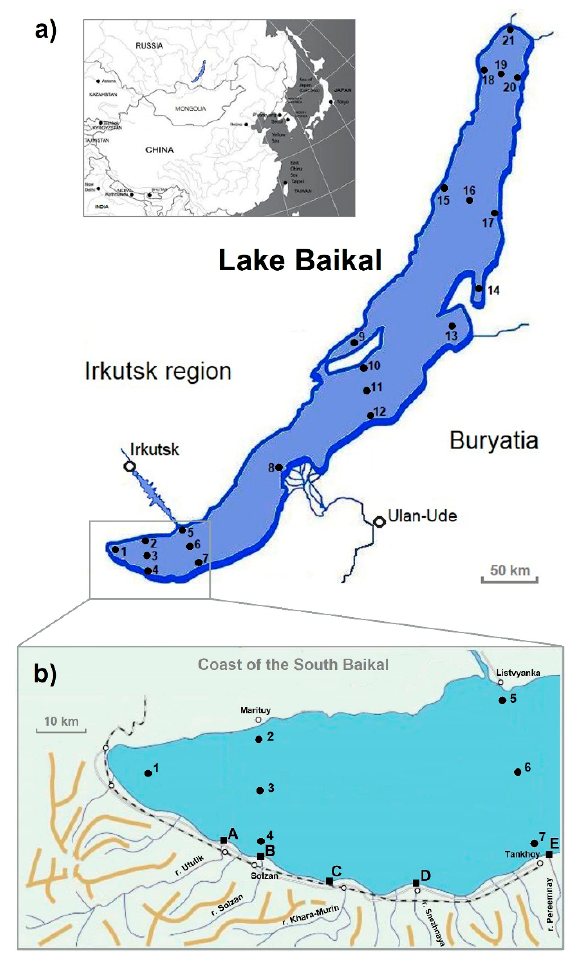
Figure 1. Map of Lake Baikal and sampling sites: ( a ) Water sampling stations in the pelagic zone of Lake Baikal; ( b ) Water sampling stations in the tributaries in the southern basin of Lake Baikal. PAHs were extracted with 25 mL of n-hexane from 1 L of unfiltered water because the concentration of suspended particles does not exceed 0.01 to 0.05% in Baikal water. PAHs on the filters with aerosol were extracted with 30 mL of n-hexane in an ultraviolet bath for 30 min. Before extraction, a mixture of deuterated naphthalene-d 8 , acenaphthene-d 10 , phenanthrene-d 10 , chrysene-d 12 , and perylene-d 12 (Supelco, Bellefonte, PA, USA) was added to water samples and filters (20 µL mixture, 1 ng/µL of each). A 1 mL aliquot was taken from the first extract; then, the extraction of water was repeated, and extracts were combined. The aliquot and the combined extract were dried over sodium